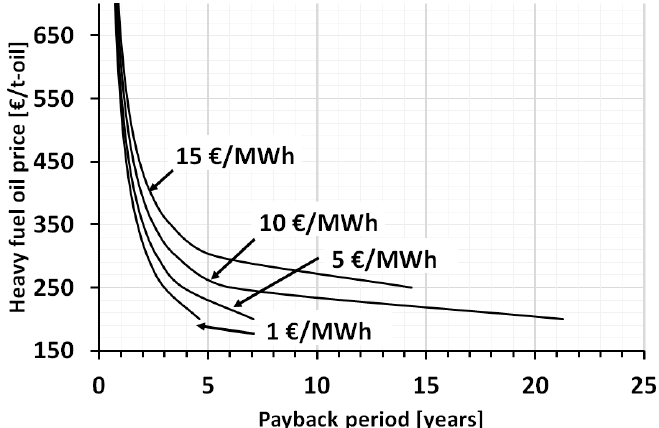
Figure 8. The payback periods when the heat prices of 1, 5, 10, and 15 € / MWh are used. The inlet air temperature of the drying air is 60 °C. All other initial values are shown in Table 5.